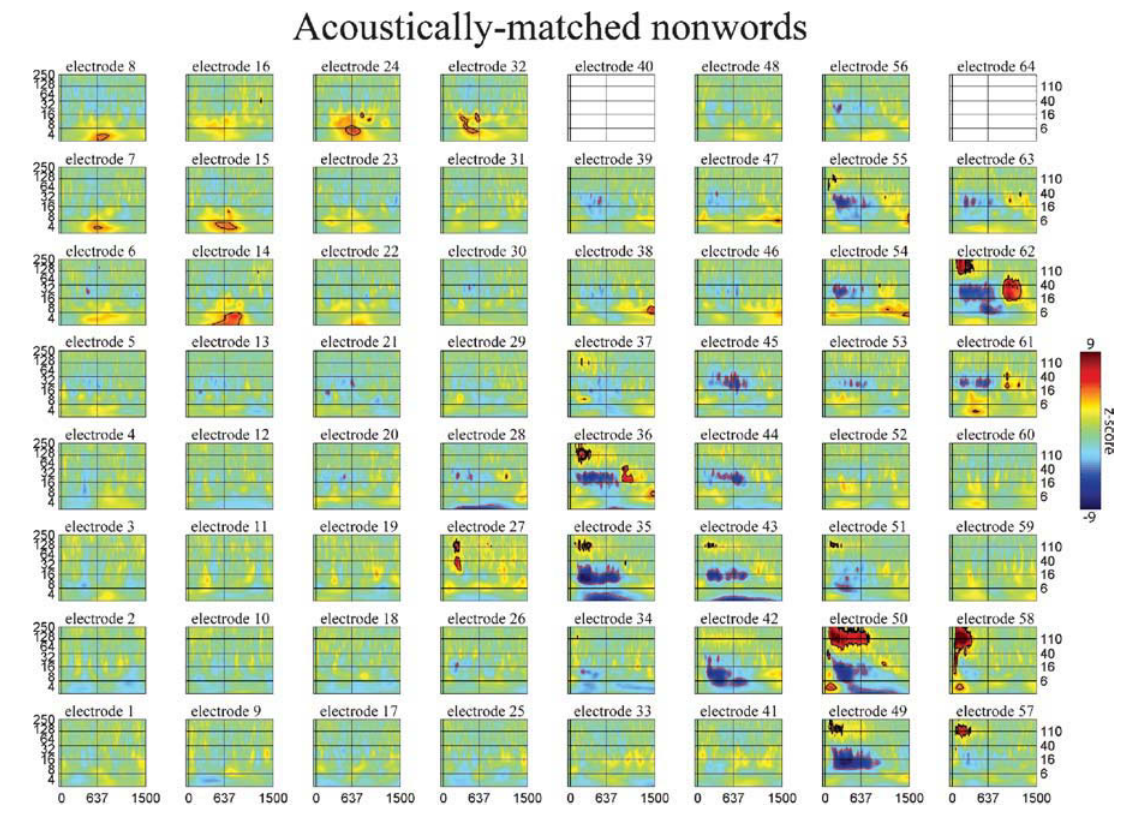
Figure 6. Event-related time-frequency plots for all electrodes in subject A in response to presentation of acoustically matched (unintelligible) nonwords. See Figure 4A and methods for electrode locations. Vertical lines indicate stimulus onset and offset. Horizontal lines indicated frequencies of interest (theta, beta, low gamma, and HG). Outermost black (red) contour line indicates significant power increase (decrease) (p<0.001, FDR corrected). See also legend for